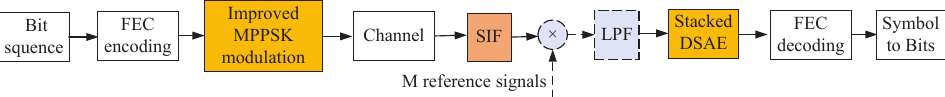
Figure 1. Block diagram of the stacked DSAE demodulation